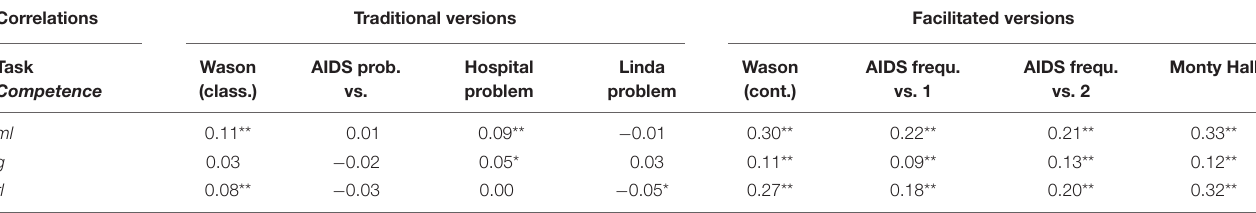
TABLE 3 | Correlations of individual items from cogIll with ml , g , and rl. Correlations